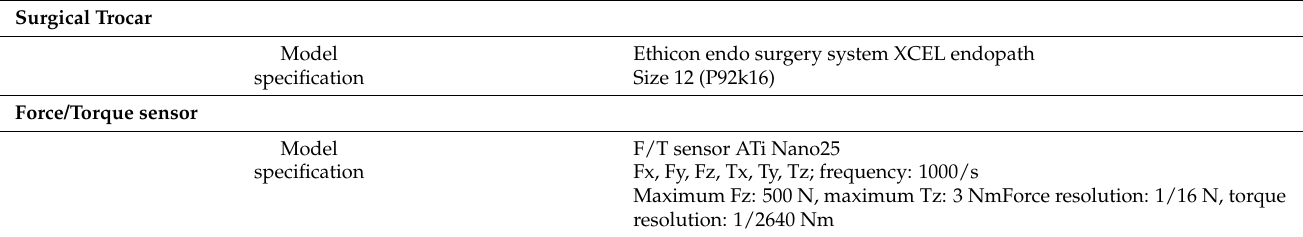
Table 1. Specification of equipment used in this